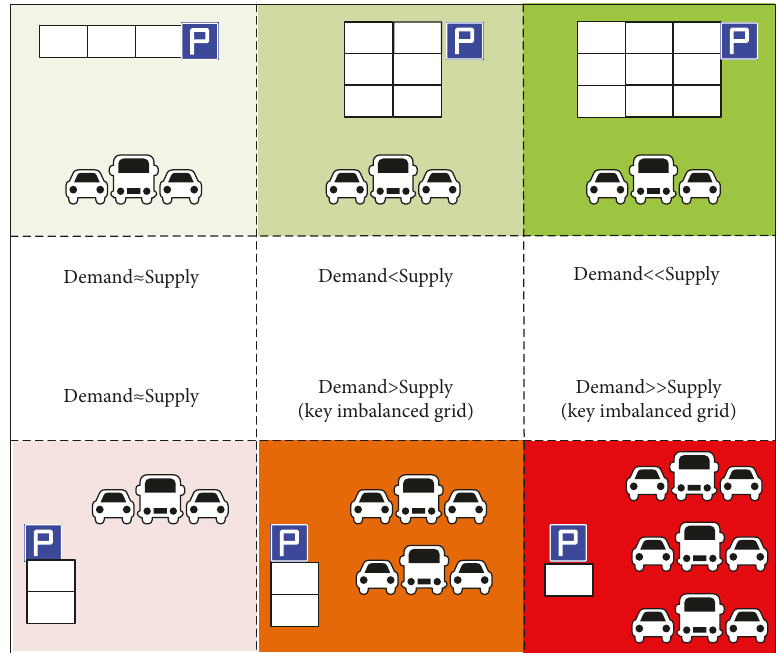
Figure 4: Classification of the relationship between 􏽢 s